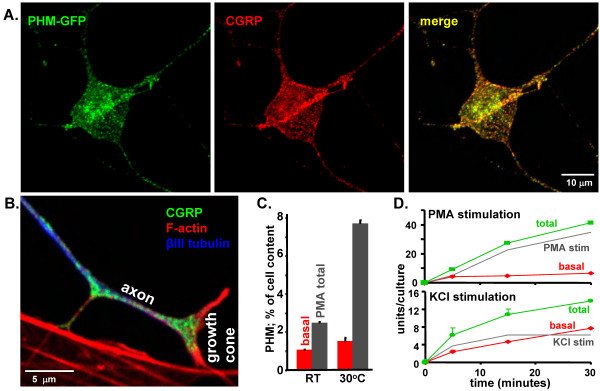
Expression of PHM-GFP allows quantification of LDCV dynamics and secretion. (A) Dissociated trigeminal ganglion neurons were transfected with vector encoding PHM-GFP and grown in culture for 2 days. Cells were fixed and processed for immunocytochemistry; PHM-GFP fluorescence was visualized in puncta throughout the cell soma and processes (green) along with CGRP (red). (B) A growth cone (labeled) and the preceding region of its axon are shown with immunofluorescent staining of CGRP (green) and βIII tubulin (blue); filamentous actin was visualized with a fluorescent phalloidin conjugate (red). F-actin enriched stress fibers in a non-neuronal cell are seen at the bottom of the image. (C) Duplicate cultures were analyzed at room temperature (23°C) and at 30°C; 30 minute medium collections were made under basal conditions and during stimulation with 1 μM PMA. Secretion was quantified by measuring units of PHM activity (pmol product/h) in basal and stimulated media and in cell extracts. (D) Cultures were stimulated for 5, 15, or 30 minutes at 37°C with 1 μM PMA or 50 mM KCl. Secretion was quantified by assaying units of PHM activity in basal and stimulated media; stimulated secretion was calculated by subtracting basal from total secretion (gray line); separate experiments with cultures of different densities were performed for PMA and KCl.